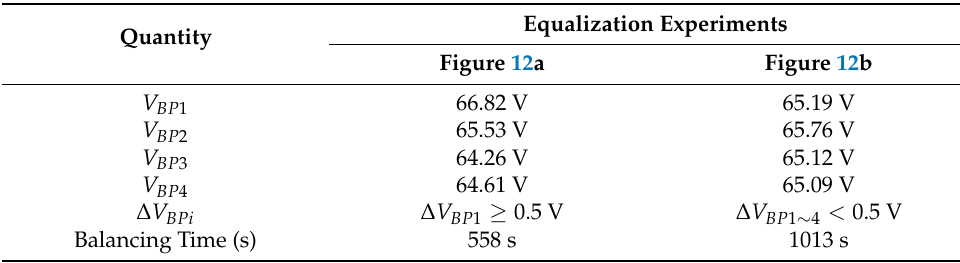
Figure 12. Comparison of the pack voltage equalization result in bimodal hybrid mode and in pure DP2P mode. ( a ) Bimodal hybrid mode. ( b ) Pure DP2P mode. Table 7. The initial pack voltage distributions and balancing